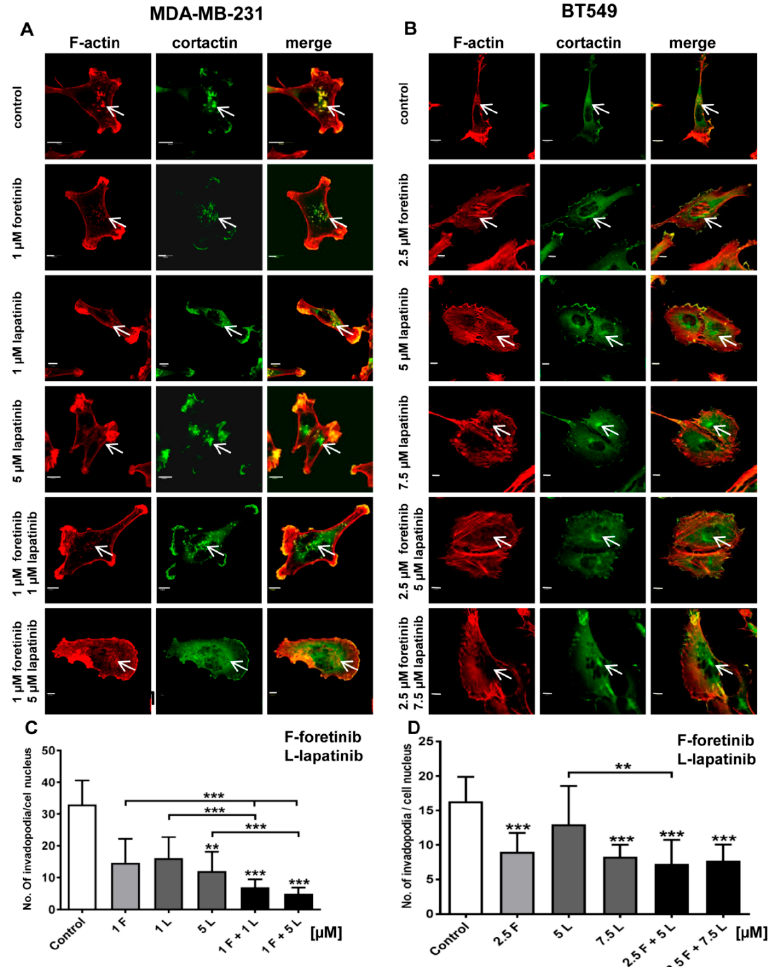
Figure 4. Influence of foretinib, lapatinib, and their combination on the subcellular organization of filamentous actin, the invadopodia marker cortactin, and the number of invadopodia in the ( A ) MDA-MB-231 and ( B ) BT549 cell lines. EGF and HGF-stimulated cells (control or treated with foretinib and lapatinib inhibitors, as indicated) on collagen type I-coated coverslips were stained for F-actin and cortactin. White arrows indicate invadopodia. Scale bar: 10 µm. Average number of invadopodia per cell nucleus in ( C ) MDA-MB-231 and ( D ) BT549 cells in control cells (treated only with EGF and HGF) and cells also treated with the indicated inhibitor concentrations. Invadopodia from 30 cells from three independent experiments were counted. Bars represent standard deviation. The statistical significance was assessed versus the control. The significance level was set at p ≤ 0.05 (*), p ≤ 0.01 (**), and p ≤ 0.001 (***).